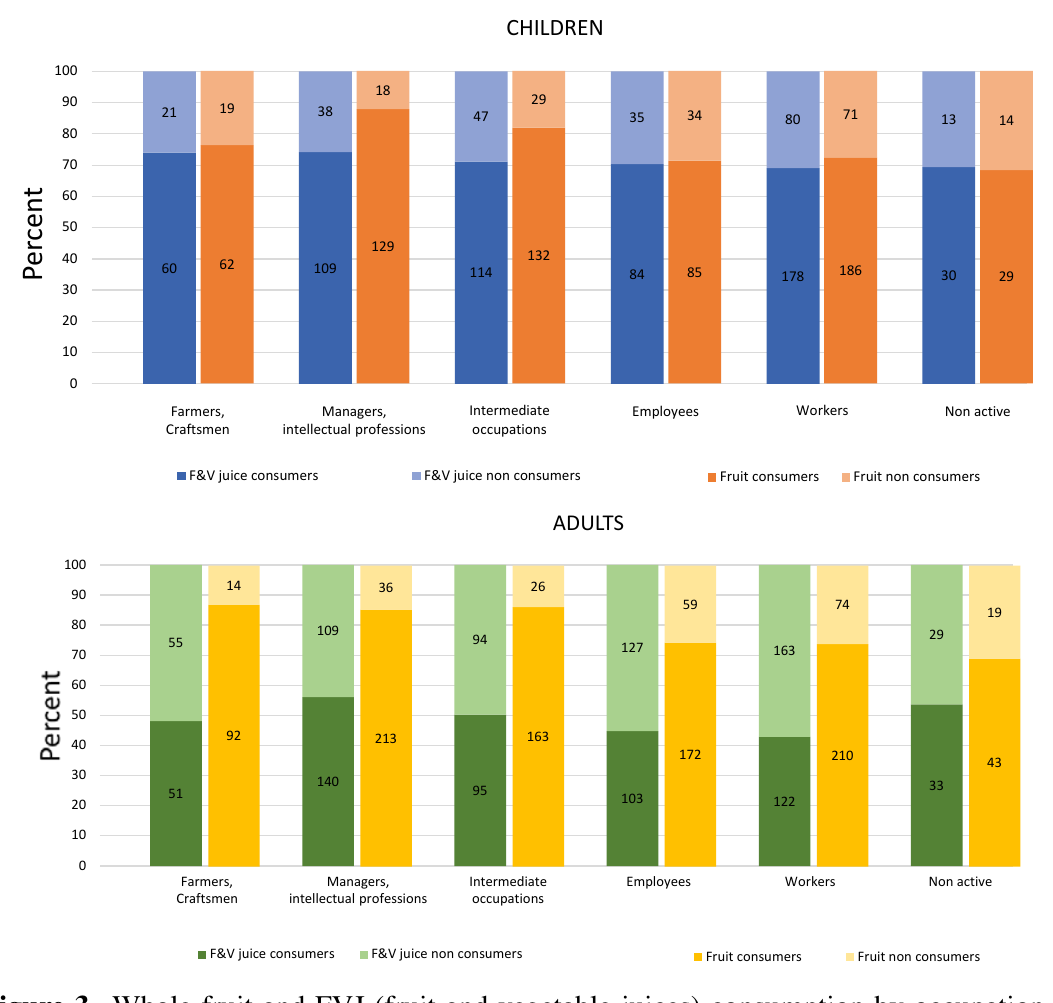
Figure 3. Whole fruit and FVJ (fruit and vegetable juices) consumption by occupation of health of household. Data are for children (3–14 years old) in the top panel and for adults (≥21 years old) in the bottom panel. Figures in the histogram bars represent the number of subjects in each category. Table 3. Multivariable regressions to assess the relation between FVJ (fruit and vegetable juices) consumption and NRF9.3 scores after adjusting for socio-demographic and lifestyle covariates. Data are presented as means and confidence intervals.